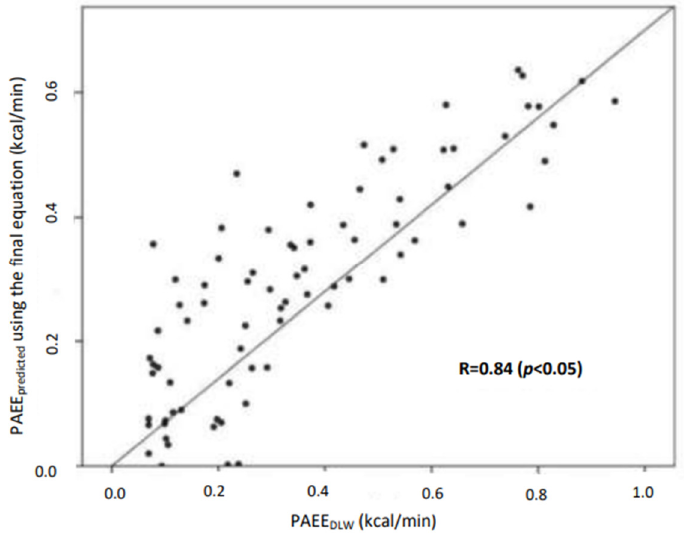
Figure 1. Regression line of the PAEE calculated using the final equation vs. the DLW technique. The distribution of the bias for PAEE calculated from the final prediction equation and assessed using DLW is plotted against the mean of the PAEE calculated from the final prediction equation and DLW according to the Bland–Altman technique (Figure 2). The mean bias of the final prediction equation was 0.06 ± 0.16 kcal/min with +0.32 kcal/min and −0.2 kcal/min being the upper and lower agreement limits (Figure 2).